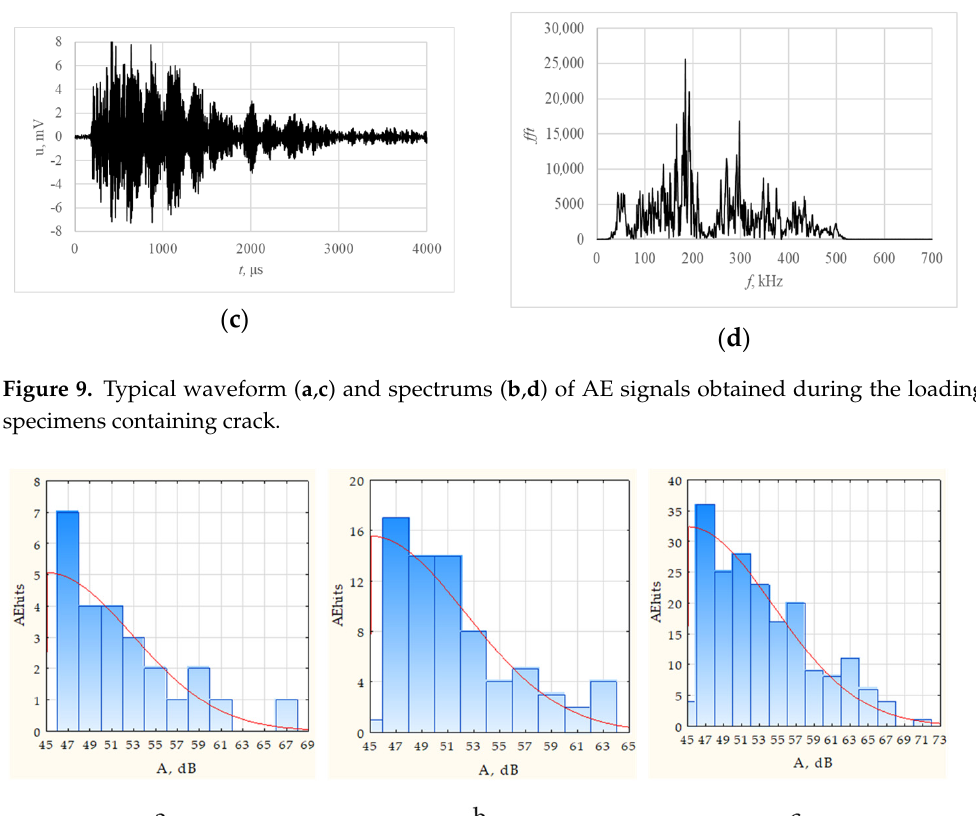
Table 3. Values of AE parameters obtained during testing.